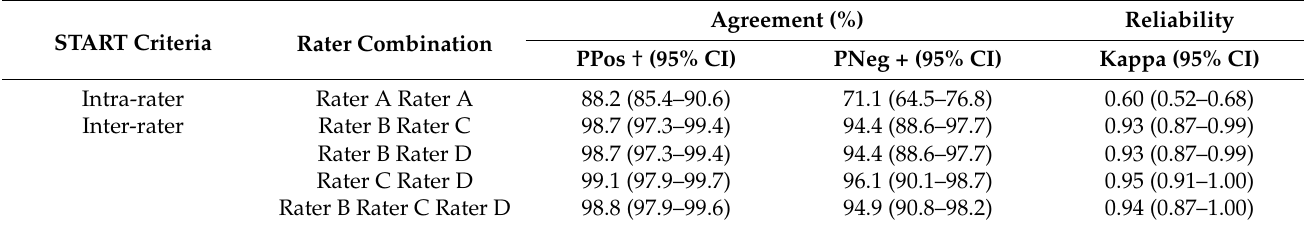
Table 3. Intra- and Inter-rater reliability and agreement from the analysis of the START criteria.